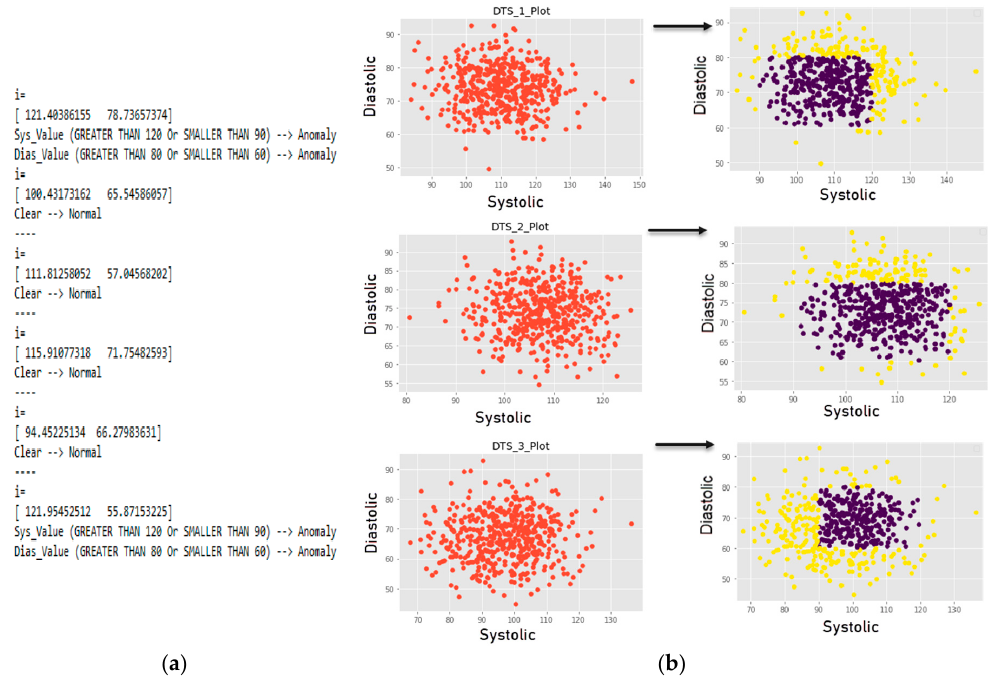
Figure 11. ( a ) Numerical example of used rules and ( b ) graphical representation of the classification.